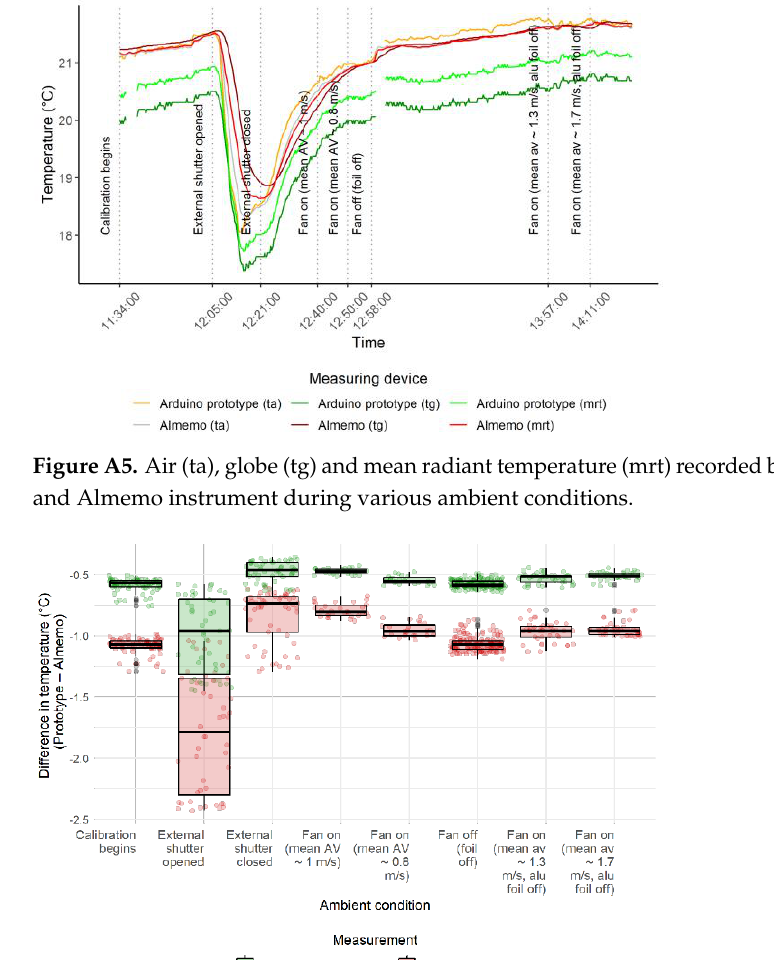
Figure A7. Infrared images of both devices during ambient condition ‘external gate opened’ ( left ) and ‘fan on’ ( right ).